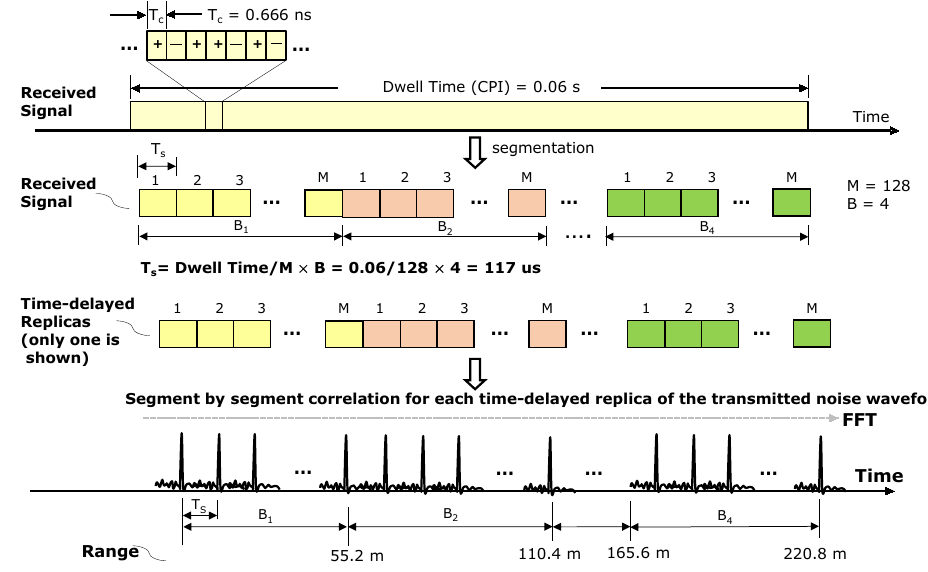
Figure 8. Processing sequences reducing FPGA resources.